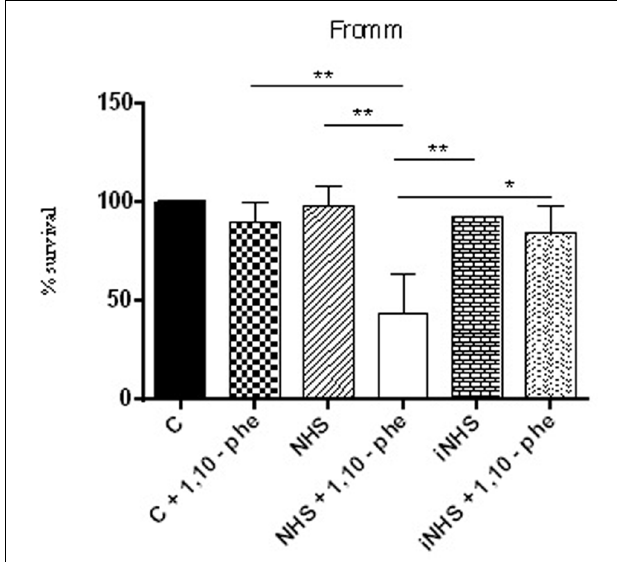
FIGURE 7 | Inhibition of metalloproteases by 1,10-phenanthroline reduces pathogenic leptospire survival in the serum. Suspensions of L. interrogans serovar Kennewicki strain Fromm was incubated with EMJH containing 10% BSA (C; negative control); 40% normal human serum (NHS) or heat inactivated serum (iNHS) in the presence or absence of 5 mM 1,10-phenanthroline. The number of viable leptospires observed in the negative control (C) was considered 100 % survival. Statistical analyses were performed using ANOVA. ∗ p ≤ 0.05, ∗∗ p ≤